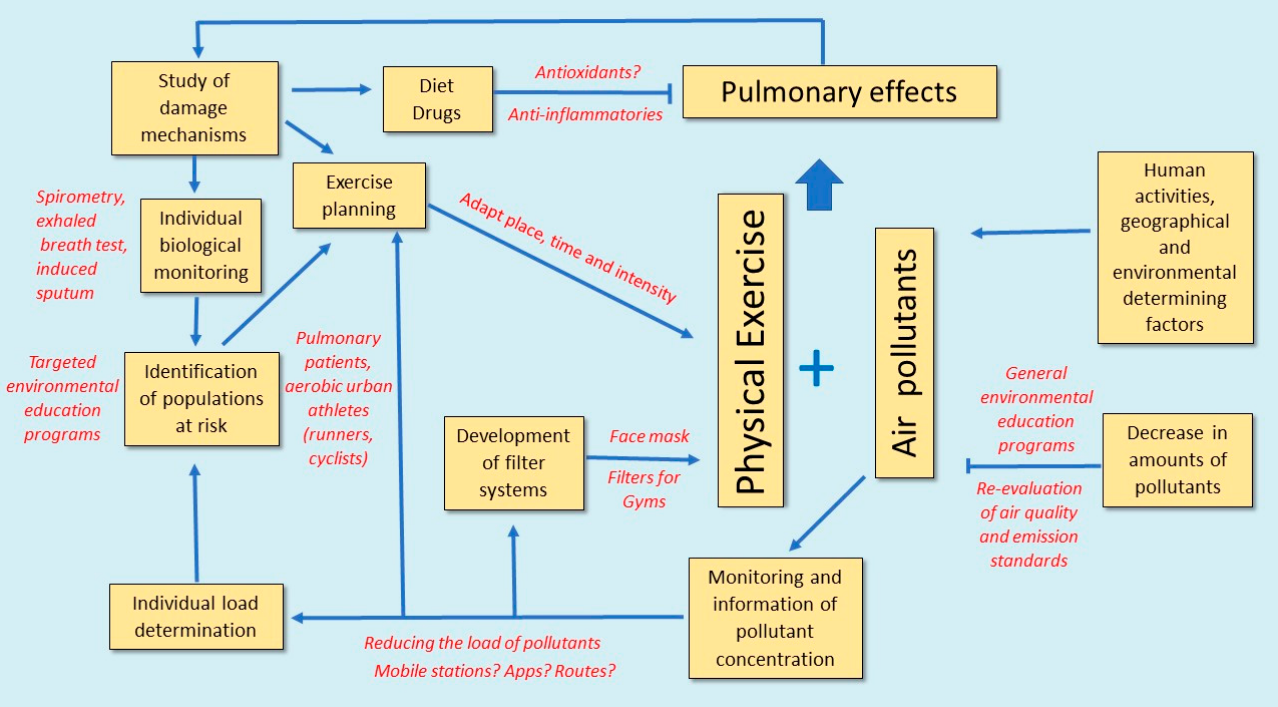
Figure 2. Overview of future goals and strategies to optimize the performance of exercise in polluted conditions.